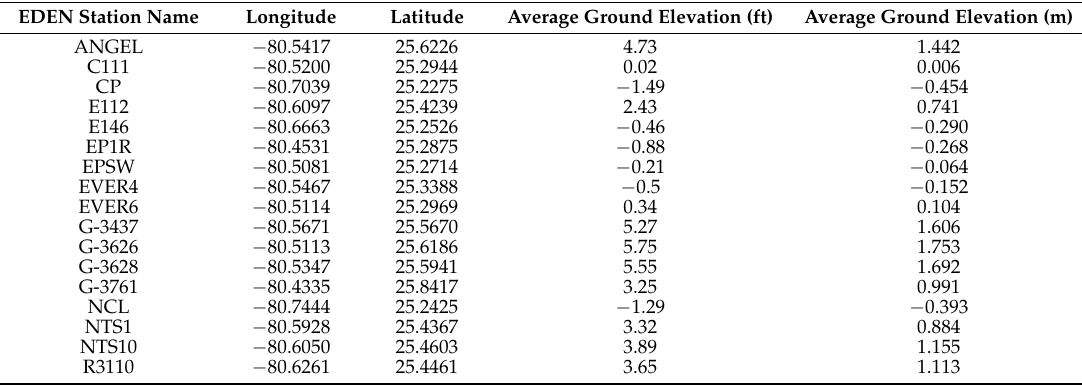
Table 5. Location of Everglades water depth gages (decimal degrees, WGS 1984) and average ground elevation (above the North American Vertical Datum of 1988) at gage sites used in this study.